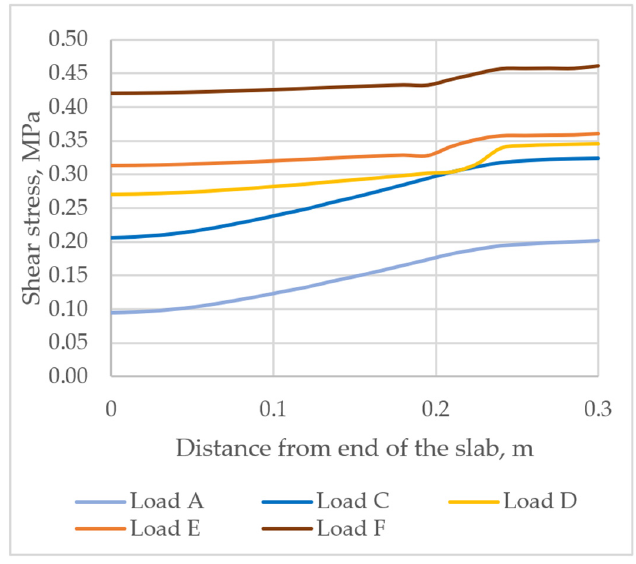
Figure 11. Shear stress τ SY in the bond between the layers.